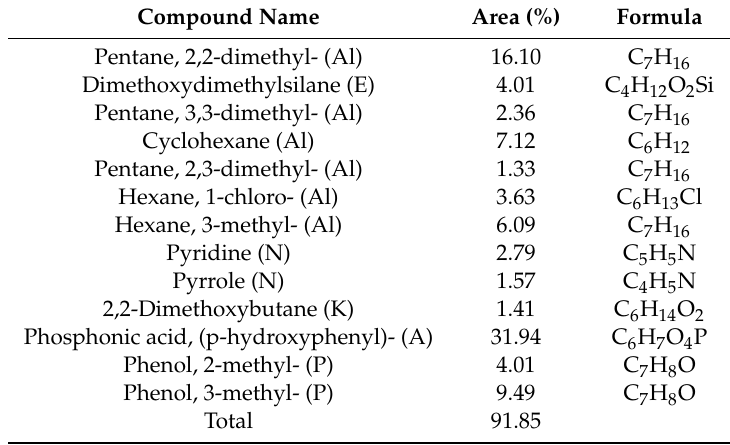
Table 4. Chemical compounds detected in bio-liquid obtained from gasification of Napier grass at 850 ◦ C and equivalence ratio (ER) of